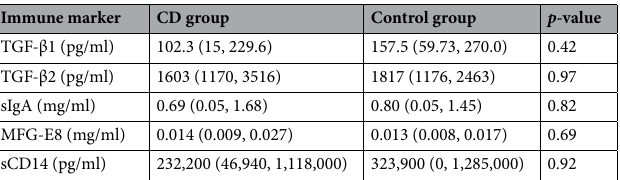
Table 1. Immune markers in the breast milk from mothers of celiac disease (CD) and control children (median, quartiles Q1, Q3).